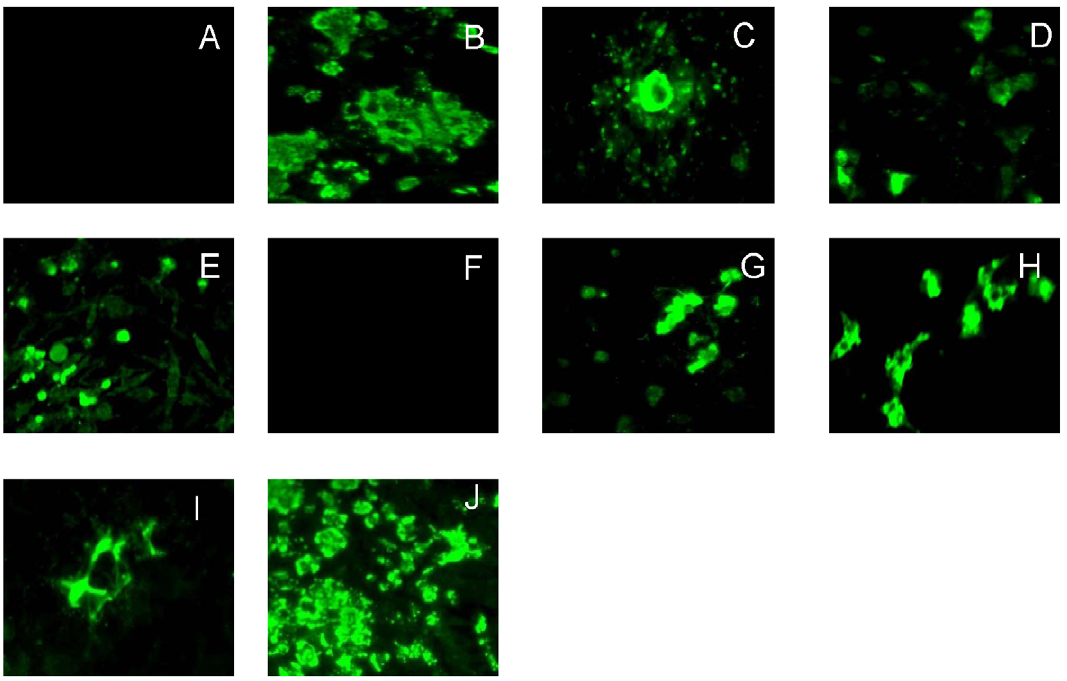
Figure 2. Immunofluorescence visualization of foci formed in DF-1 cells infected with each of the 9 APMV serotypes. Mice were infected with each of the APMV serotypes and lungs were harvested 3 dpi and homogenized, and the clarified supernatants were inoculated onto DF-1 cells that were incubated 4 days under methycellulose prior to immunostaining with polyclonal antiserum specific to the N protein of the respective serotype. Viruses: APMV-1 (panel B), APMV-2 (panel C), APMV-3 (panel D), APMV-4 (panel E), APMV-5 (panel F), APMV-6 (panel G), APMV-7 (panel H), APMV-8 (panel I), APMV-9 (panel J), and mock-infected (panel A).